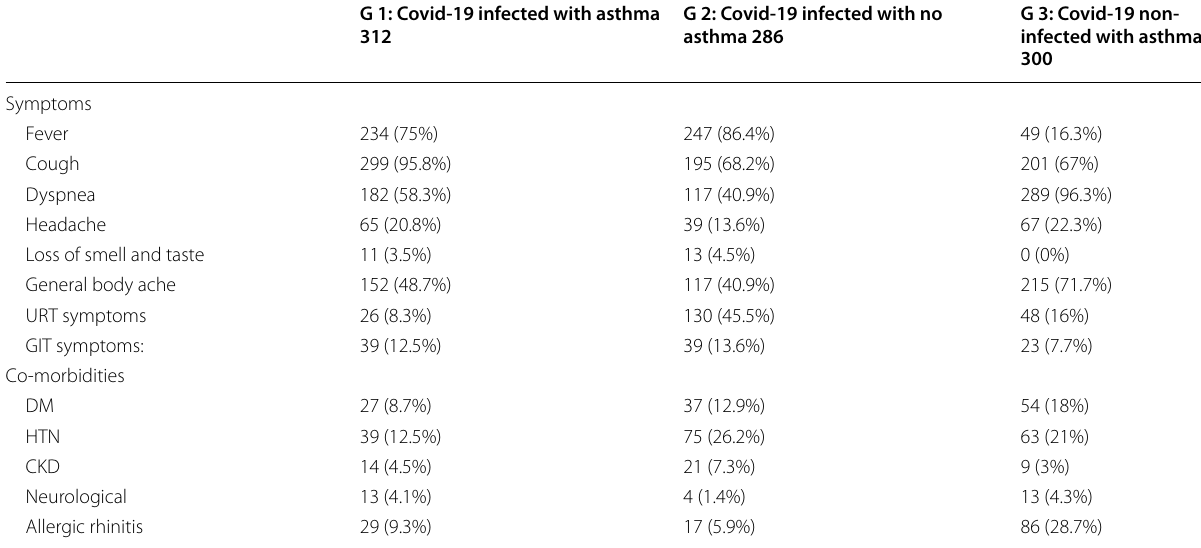
Table 2 Presenting symptoms and